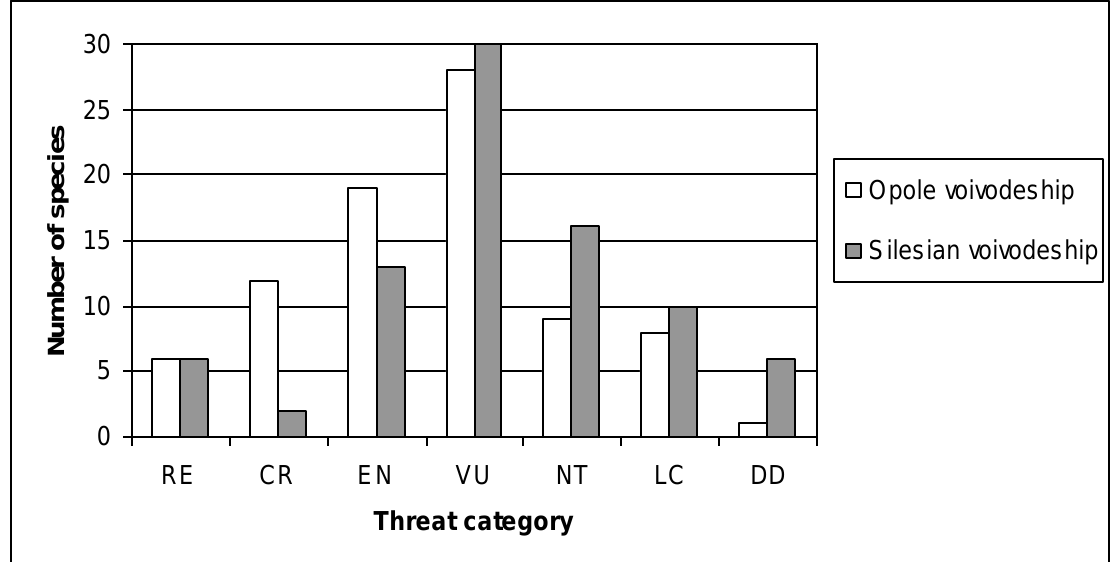
Fig. 3. Phytosociological affiliation of species assigned to a particular threat category in Opole voivodeship (see abbreviation key for Table 1)